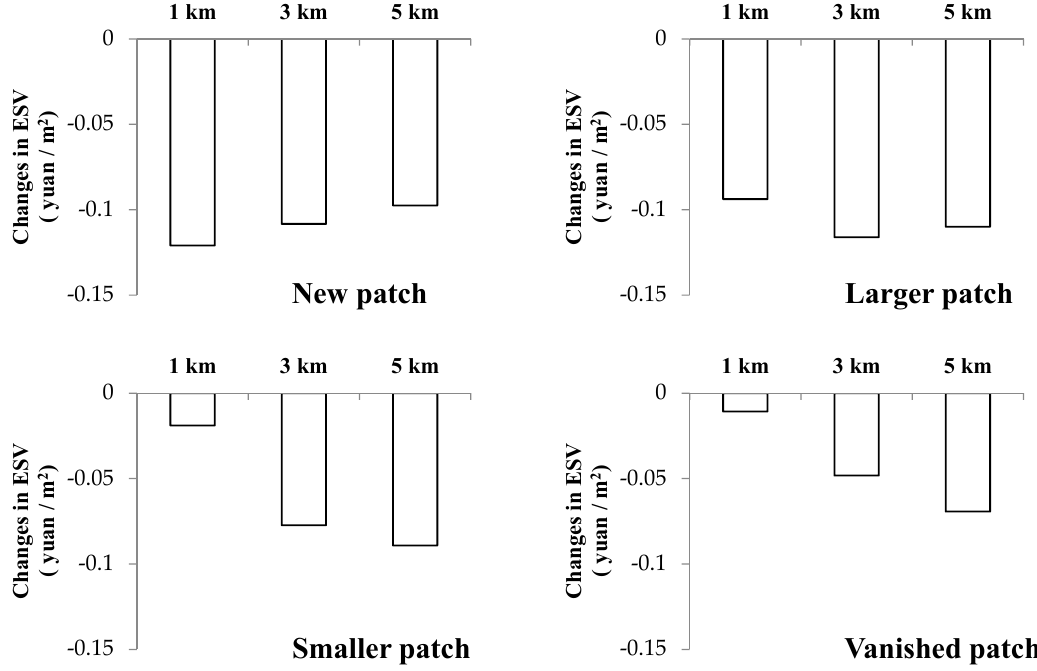
Figure 5. Changes in land ecosystem services values within different-sized buffers.